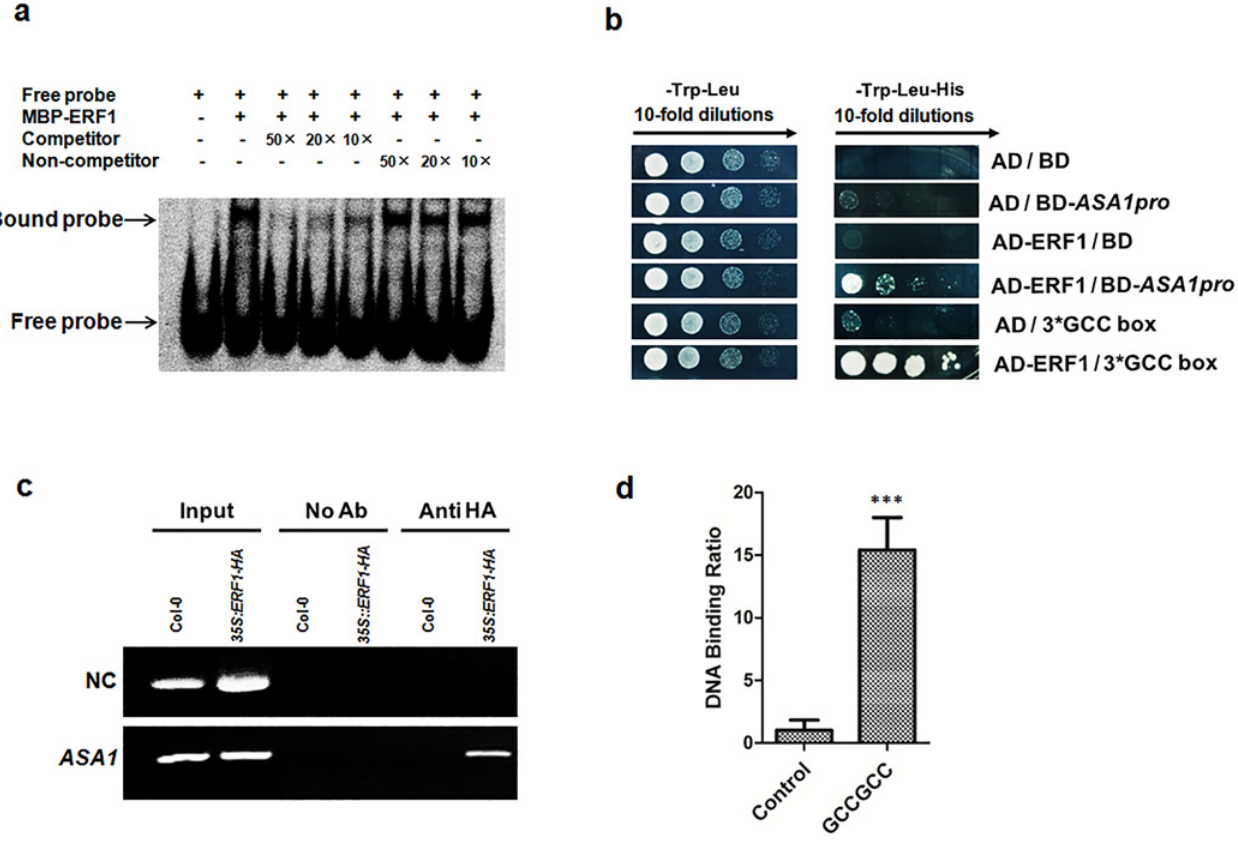
Fig 4. ERF1 directly binds to ASA1 promoter region in vitro and in vivo . ( a ) EMSA assay for binding to GCC-box sequence in the promoter of ASA1 by ERF1 protein in vitro . Dig-labelled probes were incubated with ERF1-MBP protein. As indicated, unlabelled probes were used as competitors, unlabelled probes with mutated GCC-box sequence were used as non-competitors, and the ERF1-MBP protein bound probers were separated from free probes by an acrylamide gel. ( b ) Yeast-one-hybrid assay. pGADT7/ERF1 (AD-ERF1) and pHIS2/ASA1pro (BD-ASA1pro) constructs were co-transformed into yeast strain Y187. AD-empty and BD-empty, AD-empty and BD-ASA1pro, AD-ERF1 and BD-empty, AD-empty and BD-3 * GCC-box were used as negative controls while AD-ERF1 and BD-3 * GCC-box were used as a positive control. ( c ) Chromatin immunoprecipitation-PCR for ASA1 promoter. Roots of 5-day-old 3 5S : HA : ERF1 and Col-0 seedlings were used. Anti-HA antibodies were used for the enrichment of the DNA fragments containing GCC-box in the promoter of ASA1 . The results were determined by real-time PCR. Tub8 was used as a negative control (NC). ( d ) Quantitative real-time PCR was performed using the same ChIP products and PCR primers flanking GCC-boxes in ASA1 promoter as in c . The region of ASA1 that do not contain GCC-box was used as negative control. Values are mean ± SD of three replicas ( *** P < 0.001). Asterisks indicate Student ’ s t-test significant differences.